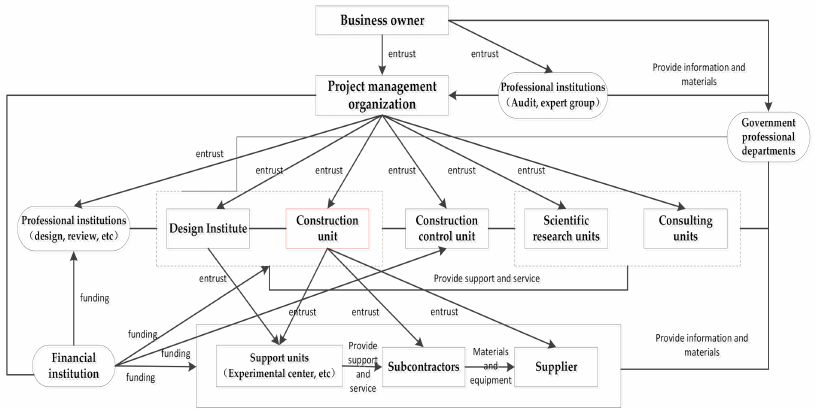
Figure 6. Interaction between construction subject and its